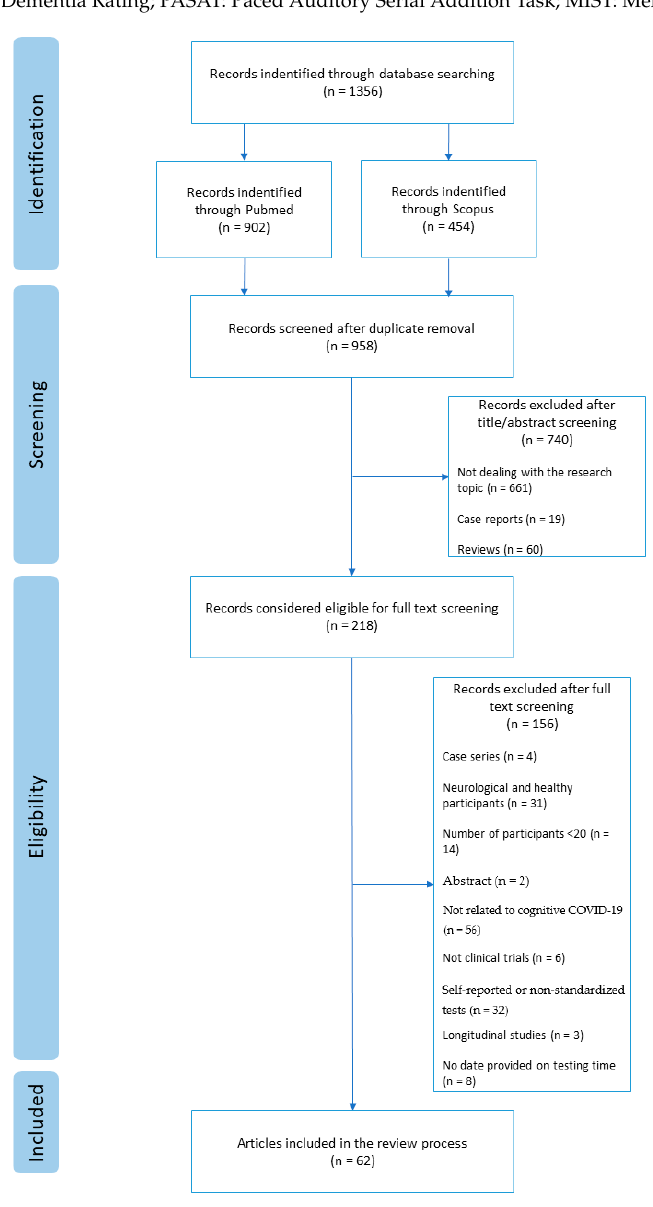
Figure 1. Flow diagram of review process.